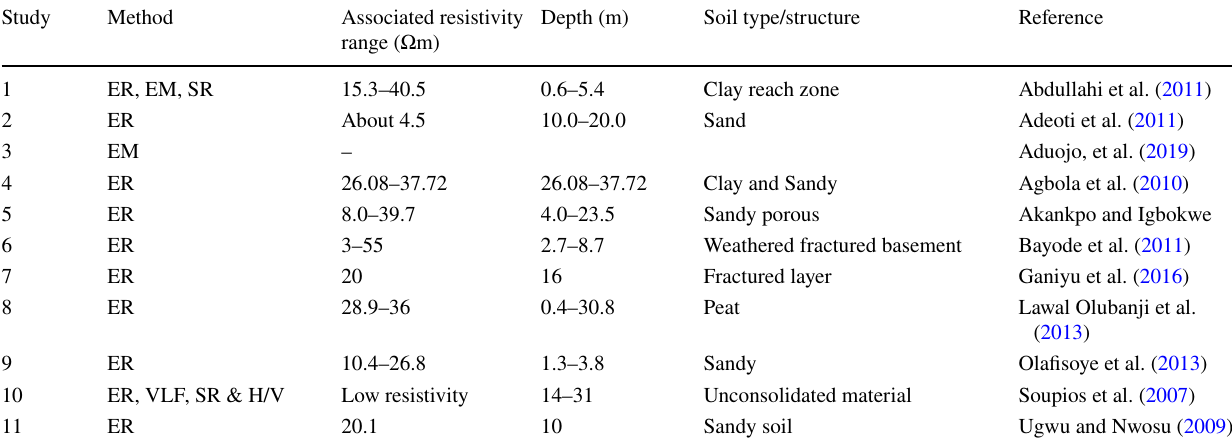
Table 3 Geophysical methods adopted by refereed researchers